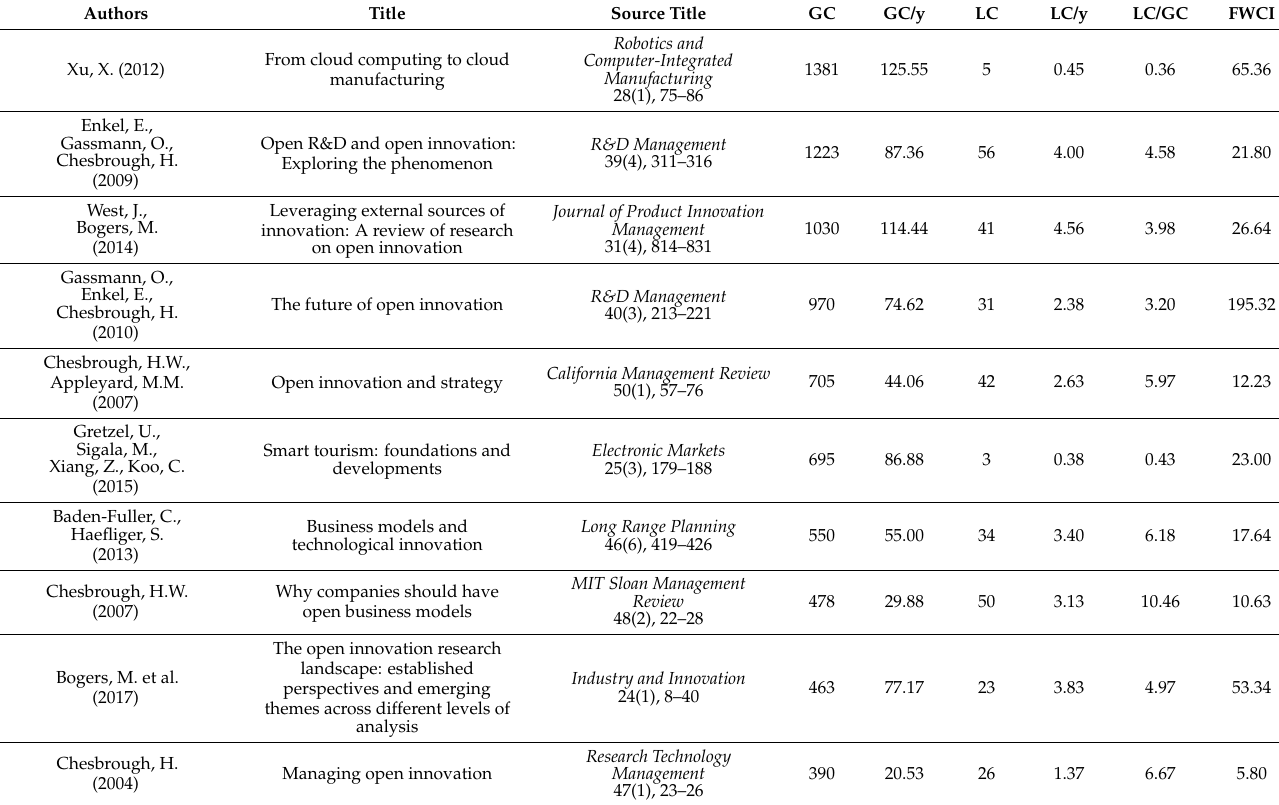
Table 2. Most cited publications in the BM&OI literature.